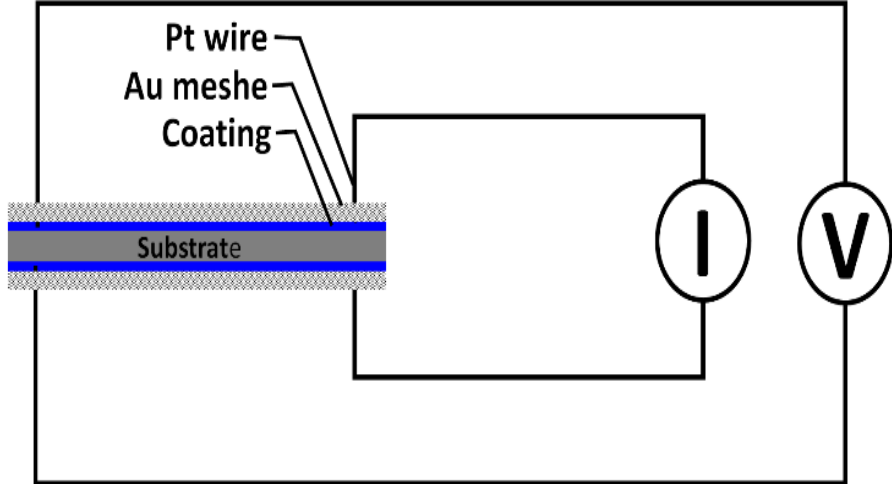
Figure 2. Schematic diagram of ASR testing measurement.